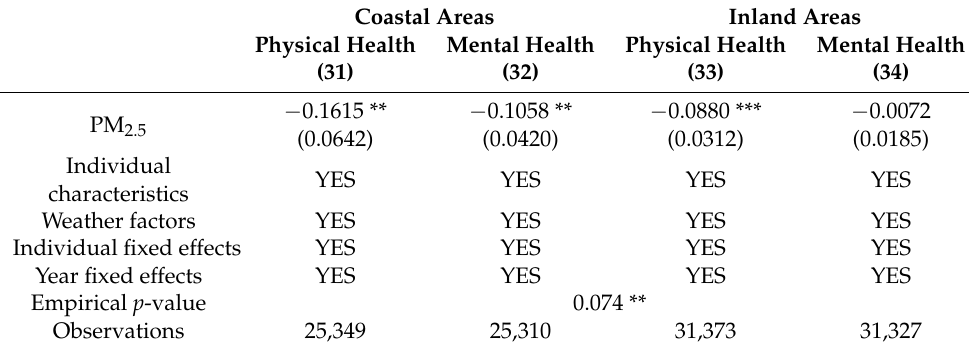
Table 10. Heterogeneity effects with coast.